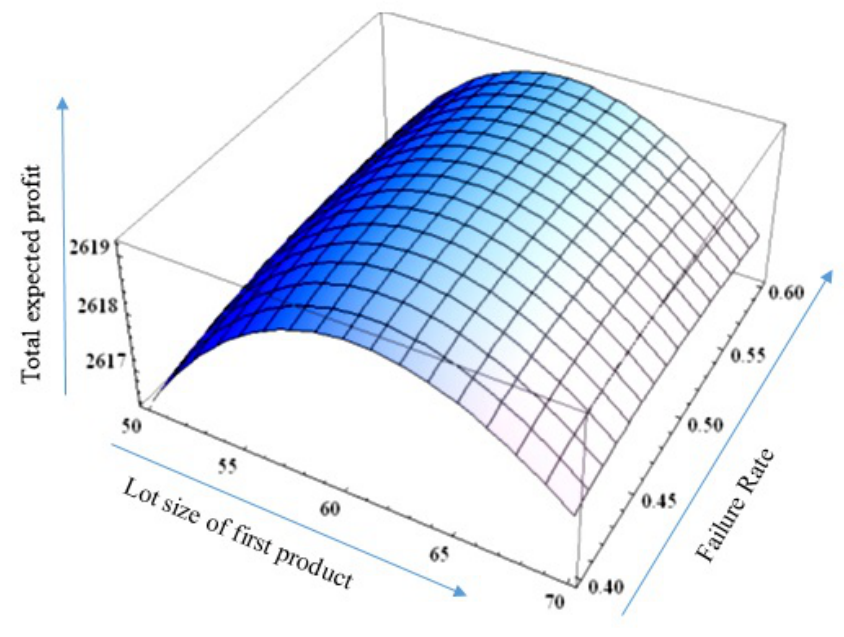
Figure 5. The total expected profit versus the production rate P 1 and the failure rate α